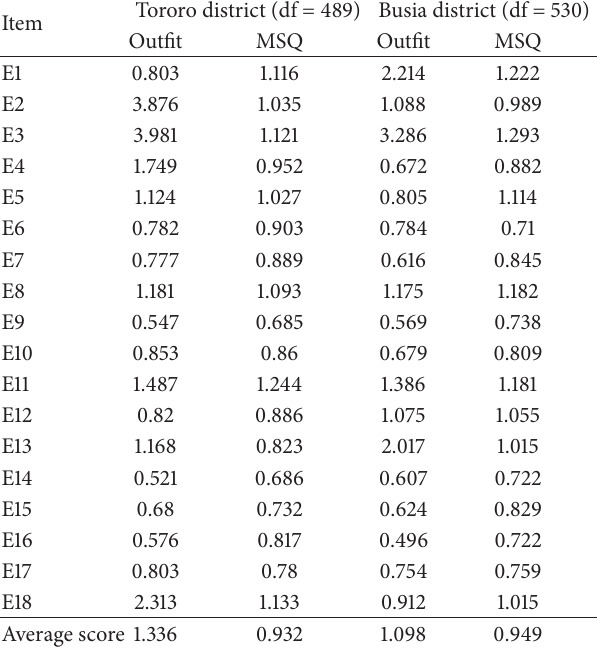
Table 6: Rasch model item fit statistics for Tororo and Busia